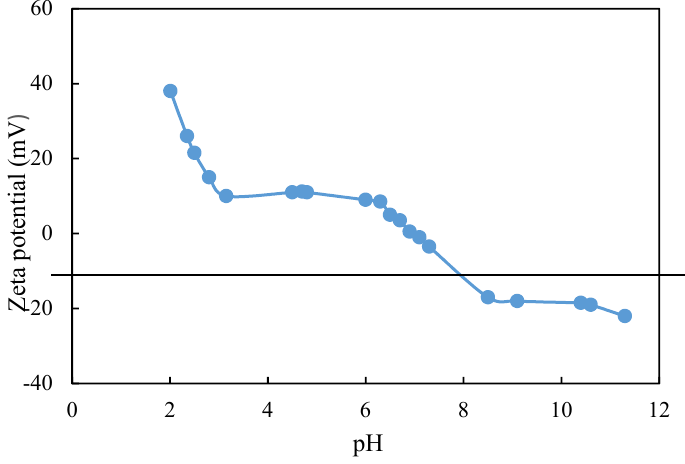
Figure 13. Zeta potential of siderite as a function of pH (after [37]).